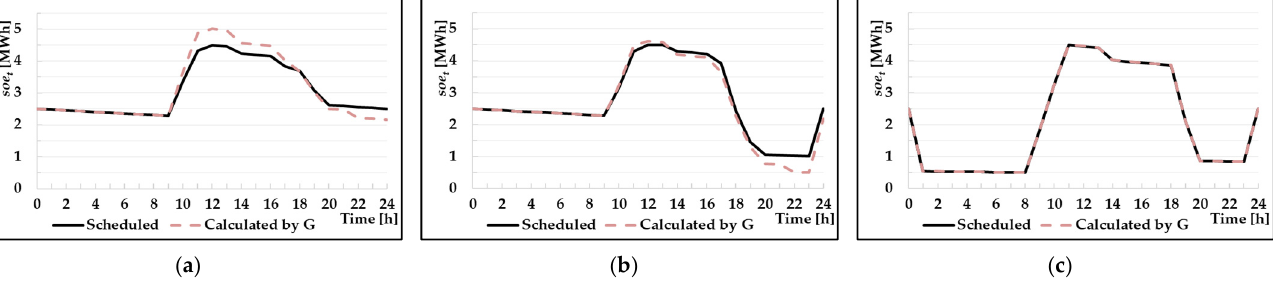
70 , ( b ) I 80 , and ( c ) II.